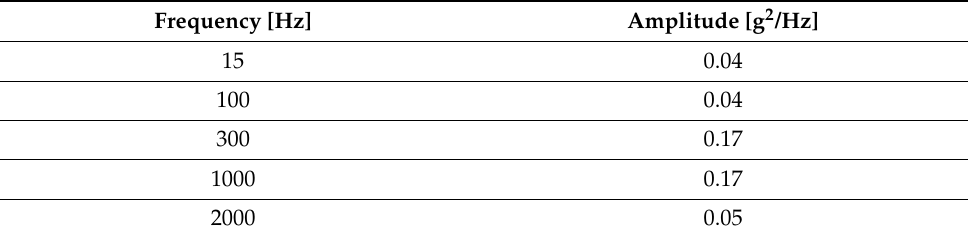
Table 2. PSD of imposed